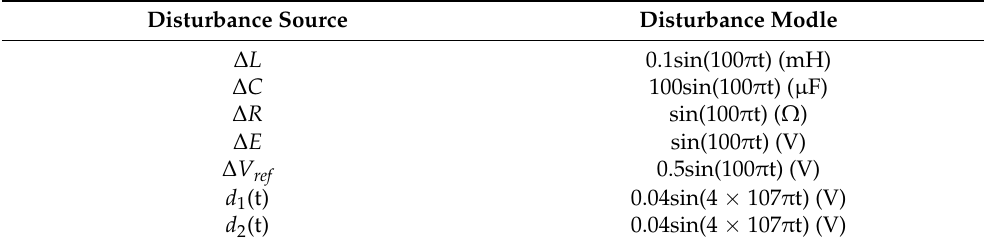
Table 3. Defined the possible disturbances in the buck converter